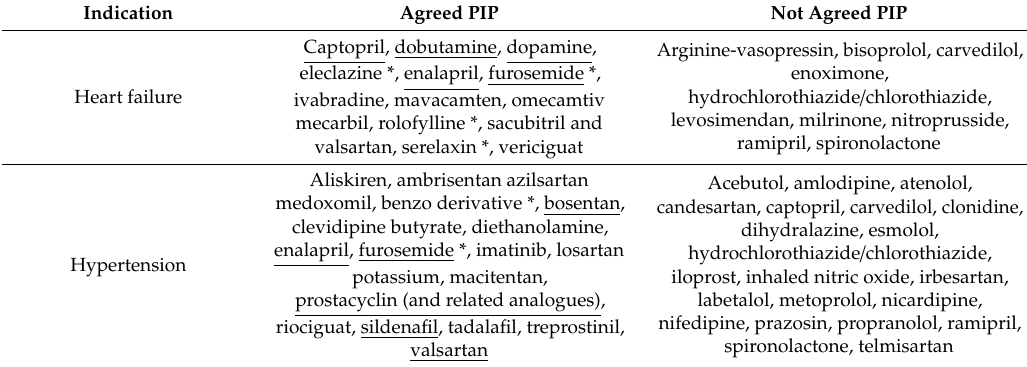
Table 4. Active substances (INN) identified on the PCMN for heart failure and hypertension. The middle and right column identifies actives with indication in these two areas with and without agreed PIPs. Underlined actives correspond to those with agreed PIPs that appear on the APN. * Discontinued PIPs. Data taken from EMA repository [16,17,20]. See methods for details on data mining.